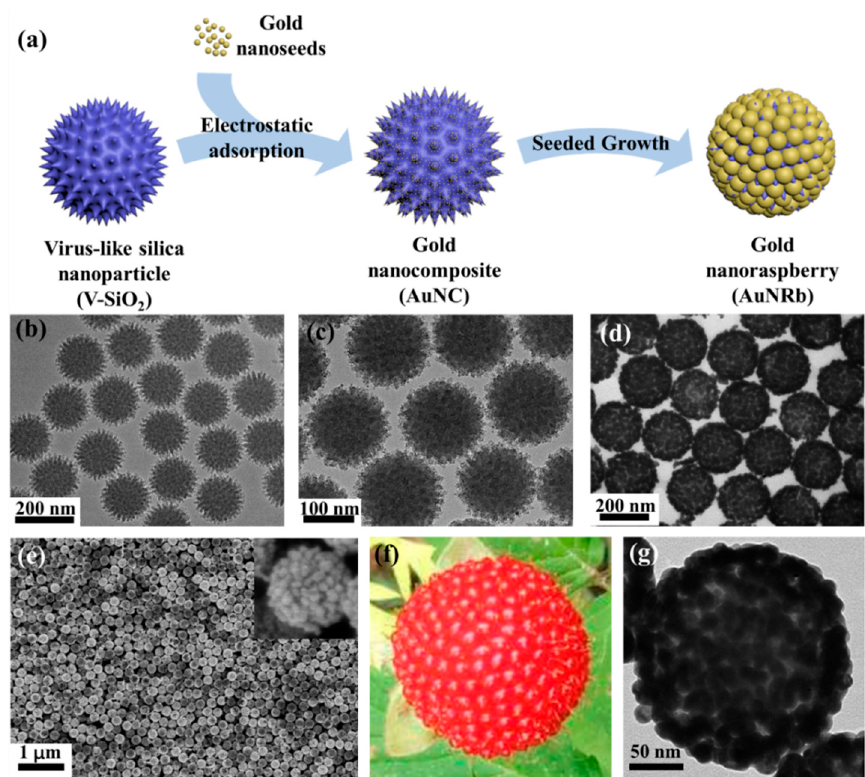
Figure 1. ( a ) A schematic diagram of the fabrication process of gold nanoraspberries (AuNRbs). Transmission electron microscopy (TEM) images of ( b ) virus-like silica (V-SiO 2 ) nanoparticles; ( c ) gold nanocomposites (AuNCs) formed by gold nanoseeds-attached V-SiO 2 nanoparticles; and ( d ) AuNRbs after the growth process. ( e ) The scanning electron microscopy (SEM) image of AuNRbs. The inset figure shows a single AuNRb. ( f ) A closeup photograph of a single raspberry fruit. ( g ) The TEM image of a single AuNRb.